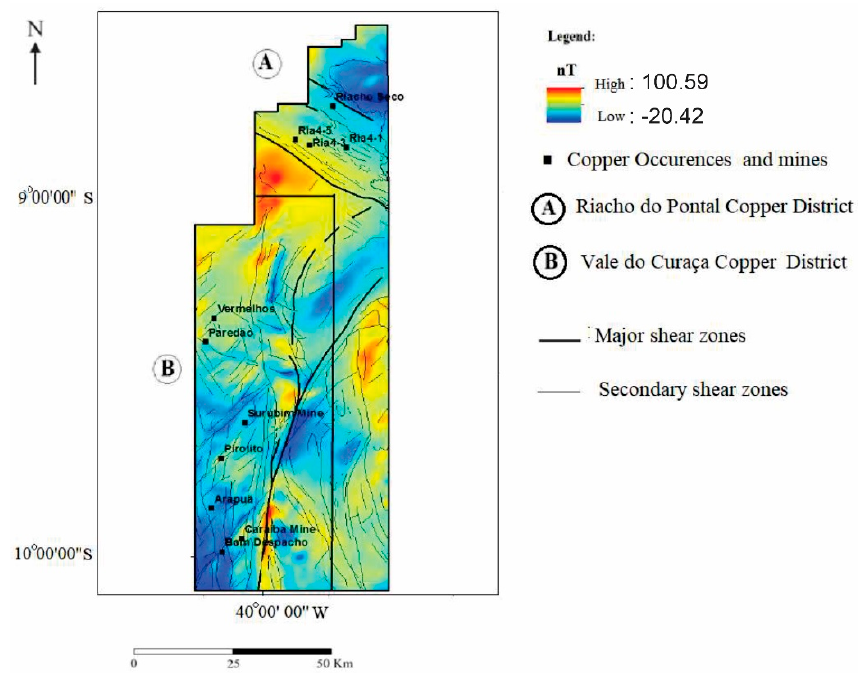
Figure 5. The reduced to pole (RTP) total magnetic intensity (TMI) data upward continued to 1000 m above ground. Major Cu mines and occurrences are shown. Block A: Riacho do Pontal district; block B: Vale do Curaçá IOCG